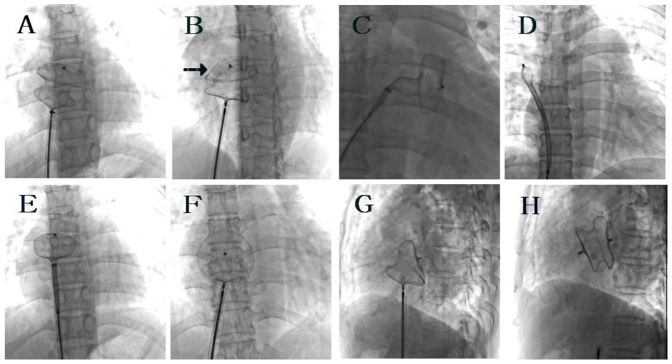
Fluoroscopy images of the Amplatzer-type septal occluder (ASO) in a patient with ASD and a deficient superior-anterior rim.(A and B) The two discs were seen separating clearly in the postero-anterior view, and the upper part of the left disc was shaped like a “beret” (arrow) in the left anterior oblique position, which demonstrated that the left disc upper part had already slipped into the right atrium. (C) The left disc was opened, and most of the waist was in the left atrium in an attempt to position the waist horizontally and to straighten the left disc. (D and E) The catheter sheath was introduced into right upper pulmonary vein, the catheter was pulled to the left atrium with the catheter orientation kept to the right upper side of the left atrium, and the whole left disc was open. (F and G) When the ASO was fully open at the ASD, the left and right discs were overlapped in the postero-anterior view and the upper part of the two discs were opened widely in a “Y” shape in the 45°–80° left anterior oblique view, the proper ASO position was assumed. (H) The ASO was released and the two discs were clearly separated.